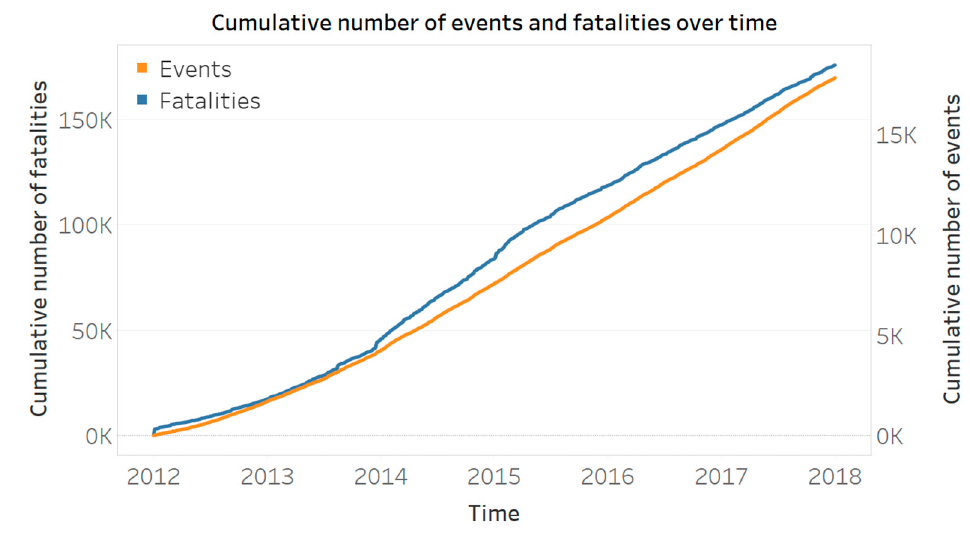
Figure 1. Cumulative number of events and fatalities over time.